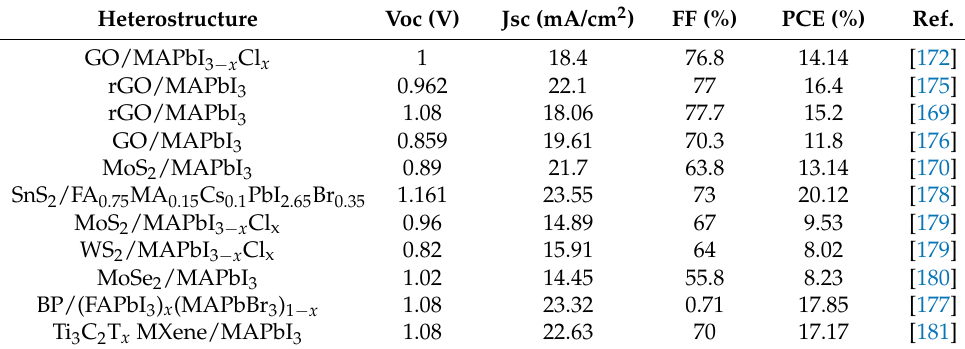
Table 5. Summarized device performance for solar cells in Section